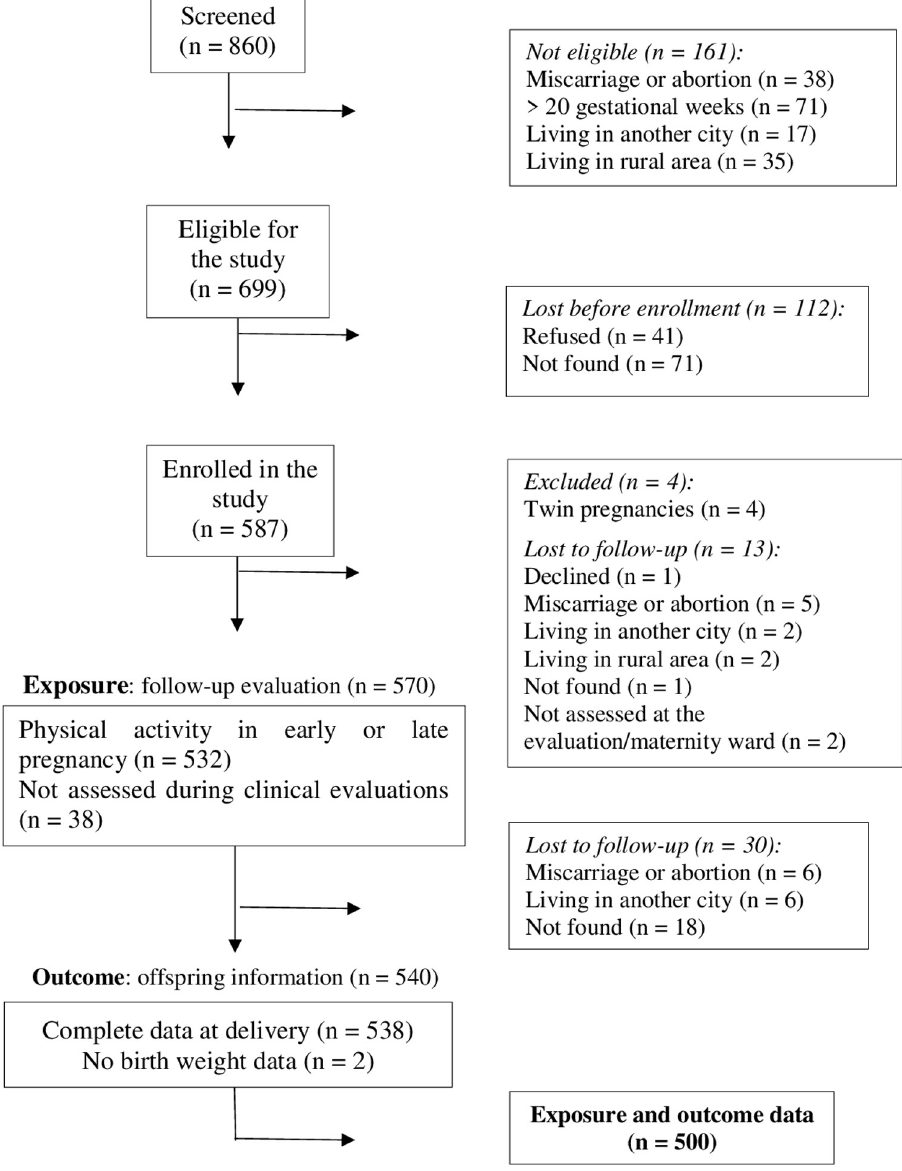
Fig 1. Flowchart of the recruitment and follow-up of the MINA-Brazil